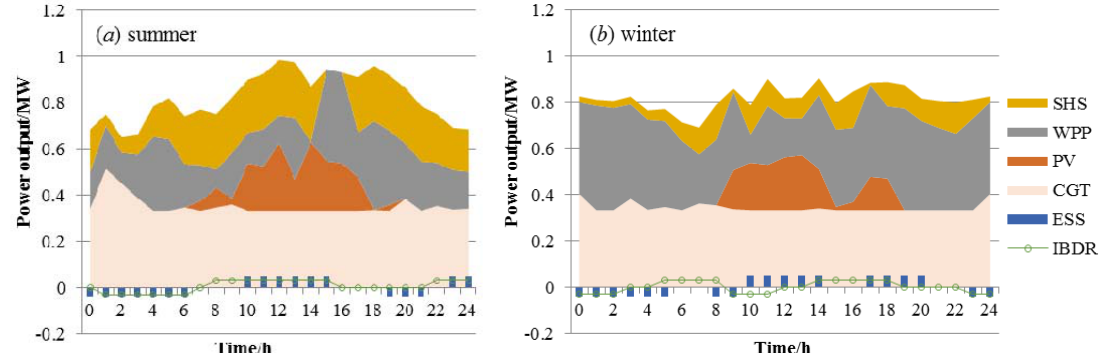
Figure 8. Output distribution of VPP power generation on typical load days in Case 2.